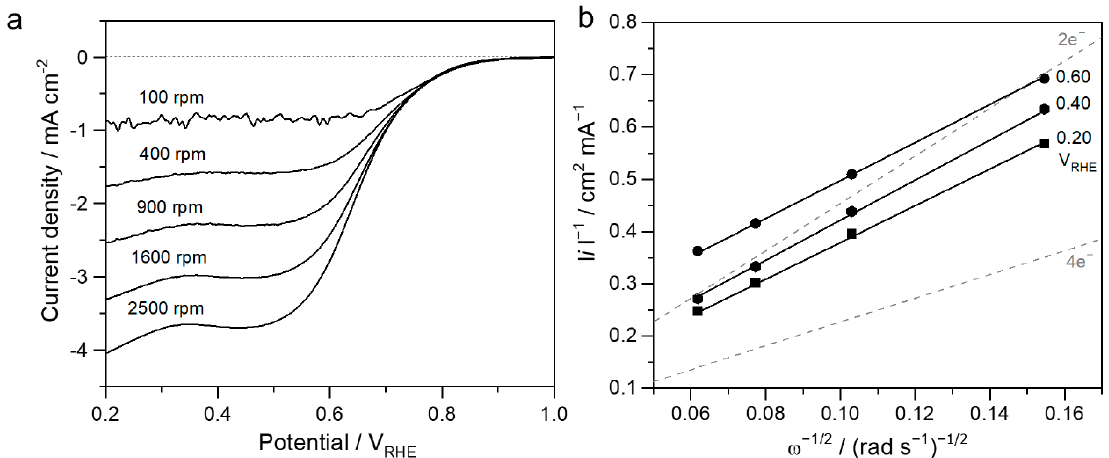
Figure 6. Hydrodynamic voltammetry of ultrafine TaO x /CB nanoparticles ( a ) LSVs of the ultrafine TaO x /CB nanoparticles prepared by electrodeposition and subsequent annealing treatment in an H 2 flow in O 2 -purged 0.1 M KOH aqueous solutions at a sweep rate of 5 mV s − 1 obtained at different revolution rates of 100, 400, 900, 1600, and 2500 rpm. ( b ) Koutecky–Levich plots, | i| − 1 versus ω − 1/2 , for the ultrafine TaO x /CB nanoparticles calculated from the LSVs in ( a ). The dotted lines indicate the slopes determined from the two- and four-electron mechanisms.